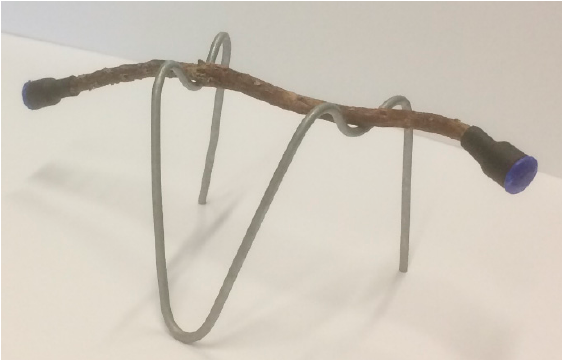
Figure 1. Sample holder and test specimen ready for climate chamber drying.